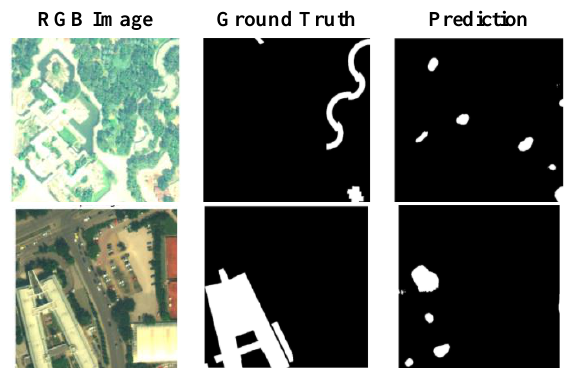
Figure 6 . Examples of tiles with low